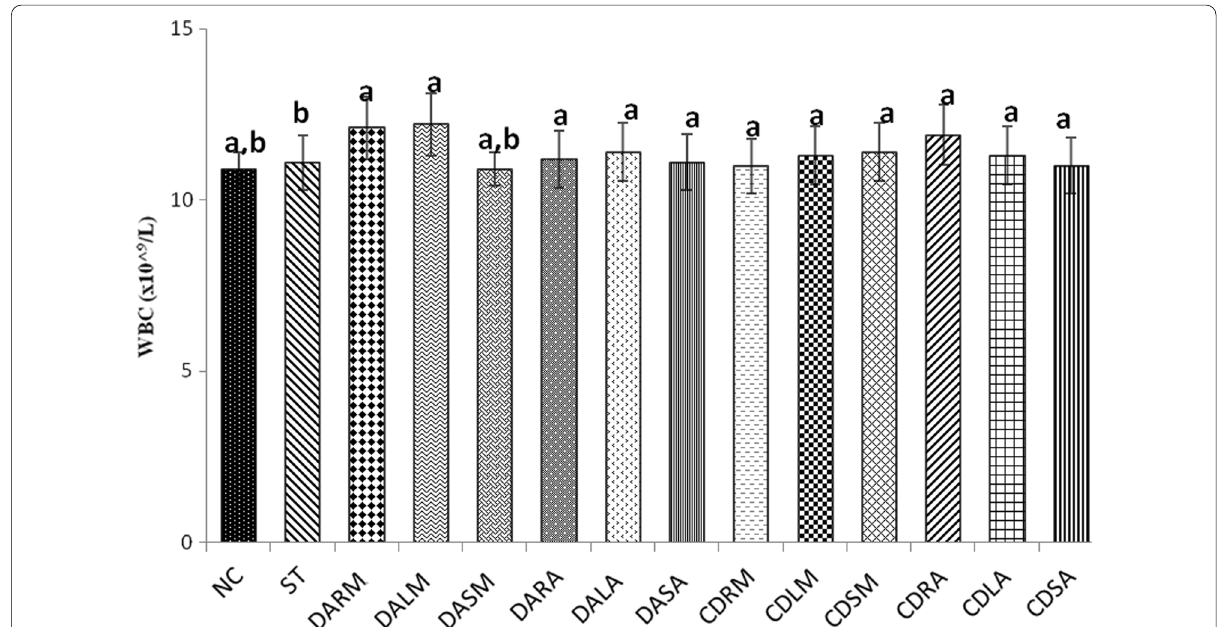
Fig. 3 Effects of methanolic and aqueous extracts of roots, leaves and stem D. arborescens and C. dependens on White blood cells (WBCs) of albino rats. Bars with similar alphabets are not statistically different ( p < 0.05)